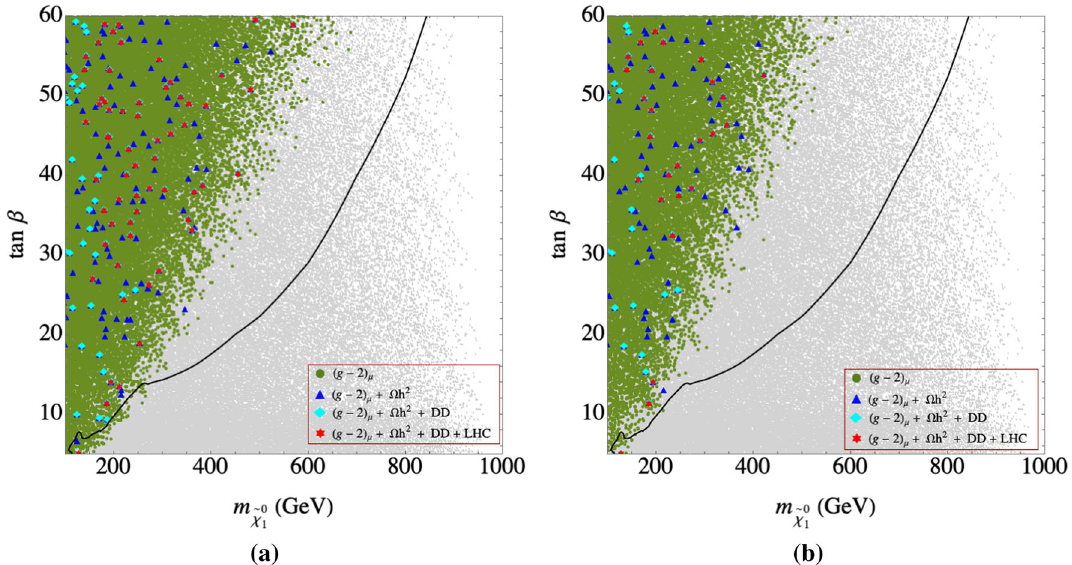
Fig. 6 The results of our parameter scan in the m ˜ χ 0 (right) from ( g − 2 ) μ ). The color coding is as in Fig. 3. The black line indicates the current exclusion bounds for heavy MSSM Higgs bosons at the LHC (see text)